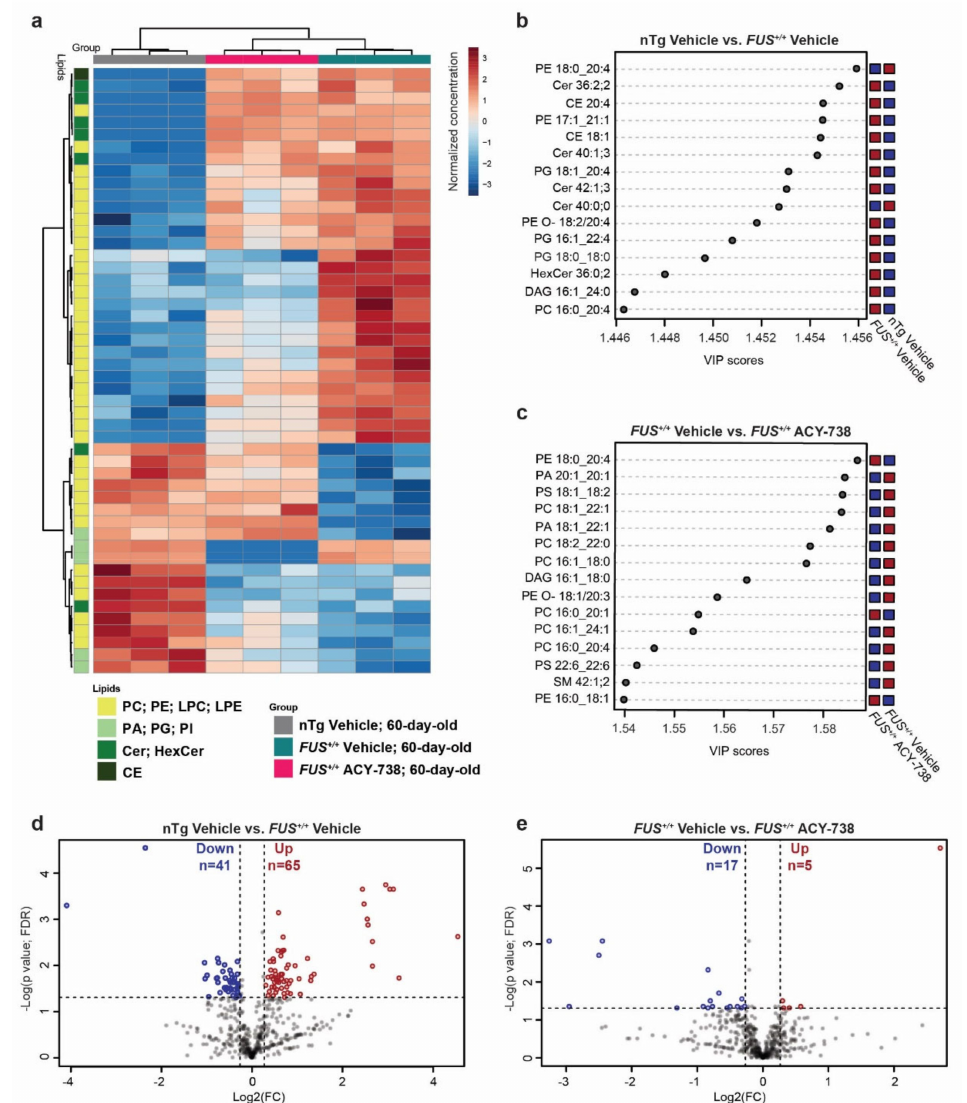
Figure 3. ACY-738 treatment ameliorates lipid homeostasis in the spinal cord of 60-day-old FUS +/+ mice ( a ) Heatmap representing 60-day-old samples and color-coded normalized concentrations of the top 50 most significantly altered individual lipid species (1-way ANOVA, p < 0.05, FDR corrected). The colors vary from deep blue to reddish-brown to indicate, respectively, values below and above the mean normalized concentrations for a given lipid species. Cluster analysis was performed to display samples in columns and lipid species in rows. Selected lipid classes of interest are color-coded in shades of green ( b , c ) Top 15 discriminant lipidic features according to the variable importance on projection (VIP) score of 60-day-old vehicle-treated nTg controls and vehicle-treated FUS +/+ mice ( b ) and vehicle-treated FUS +/+ and ACY-738-treated FUS +/+ mice ( c ). Red and blue colors indicate a high and a low normalized lipid concentration in each group, respectively. ( d , e ) Volcano plots depicting the log2 fold change (FC) of 538 lipid concentrations, comparison of vehicle-treated nTg controls to FUS +/+ mice in ( d ) and vehicle-treated FUS +/+ to ACY-738-treated FUS +/+ mice in ( e ). A fold change of 1.2 and p > 0.05 ( t -test; FDR corrected) were used to select significantly altered lipids, indicated as decreased in blue and increased in red. n = 3 per